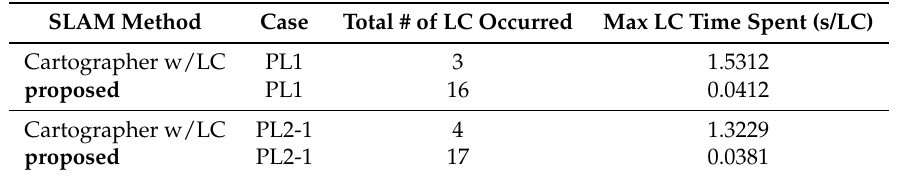
Table 2. Computational time comparison for loop closing (LC) process.